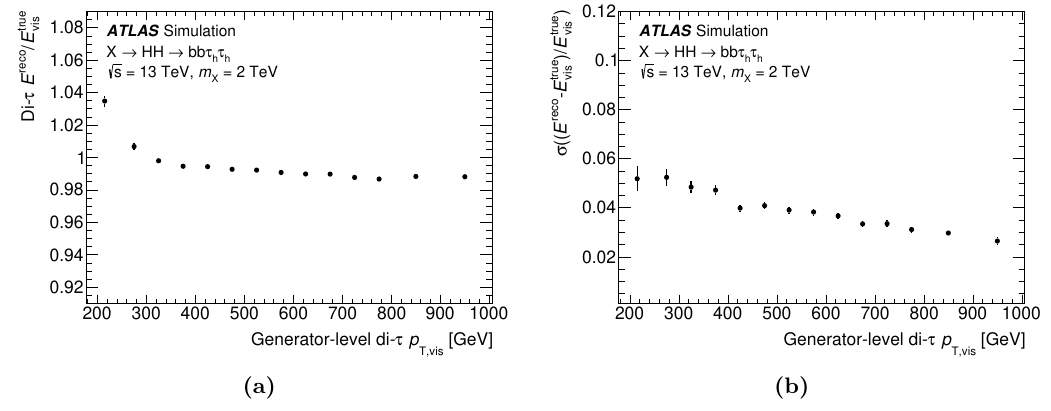
Figure 5. Energy (a) scale and (b) resolution of the di- τ reconstruction as a function of the p T of the di- τ system at generator level, computed in simulated X → HH → b ¯ bτ + τ − events, where the resonance mass is set to 2 TeV and all τ -leptons decay hadronically. The requirement of p T > 300 GeV on the seeding jet truncates the reconstructed energy distribution and leads to a degradation of the energy scale for the lower values of the p T of the di- τ system. The vertical error bars only account for statistical